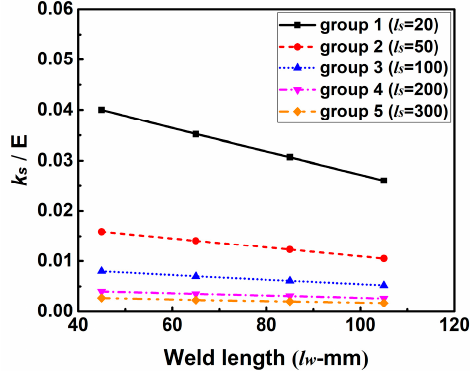
Figure 19. Influence of weld length ( l w ) on the intensity of restraint ( k s ).